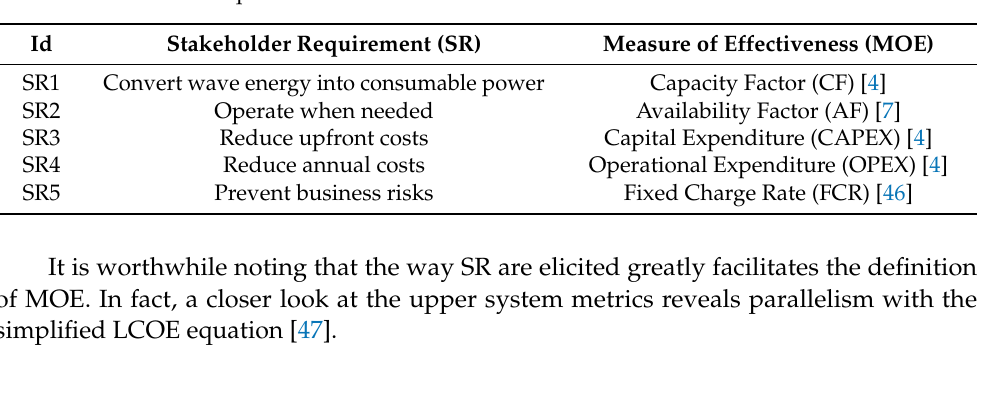
Table 7. Stakeholder Requirements and